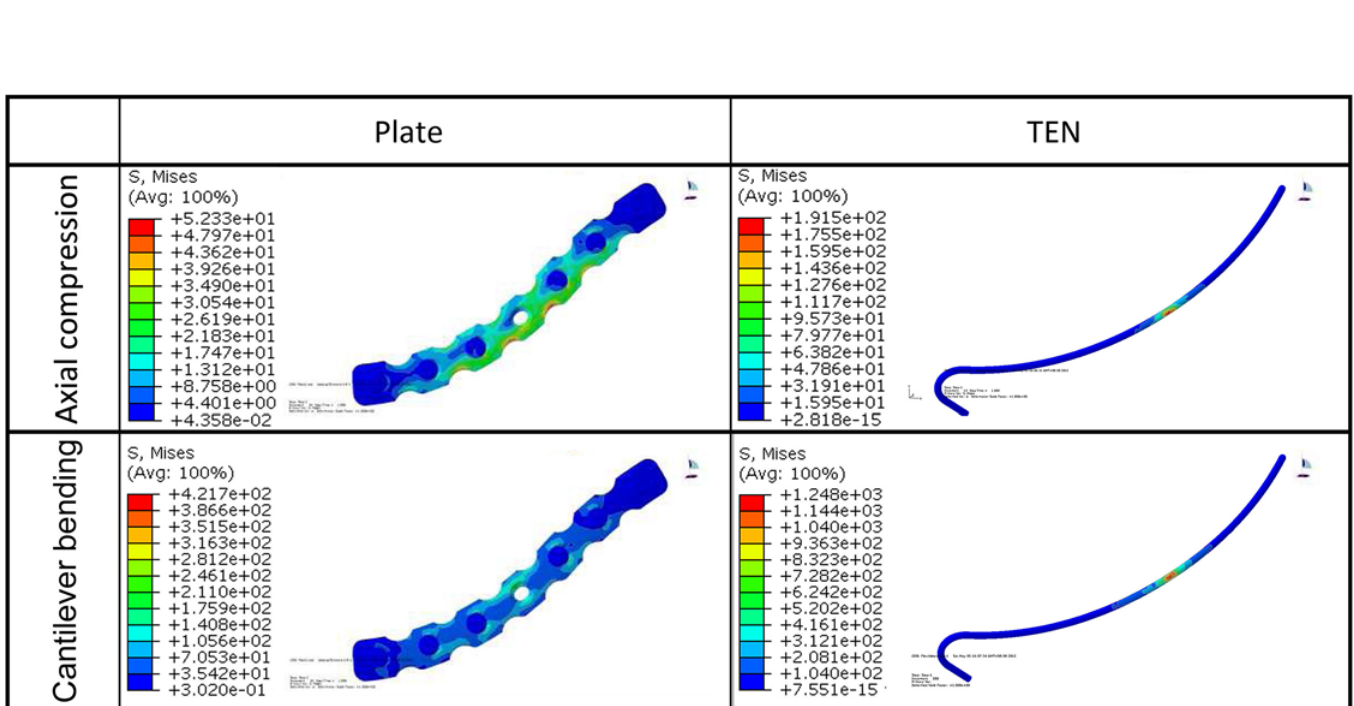
Fig 6. von Mises stress distribution in the implants for the two loading conditions. The superior view was chosen.